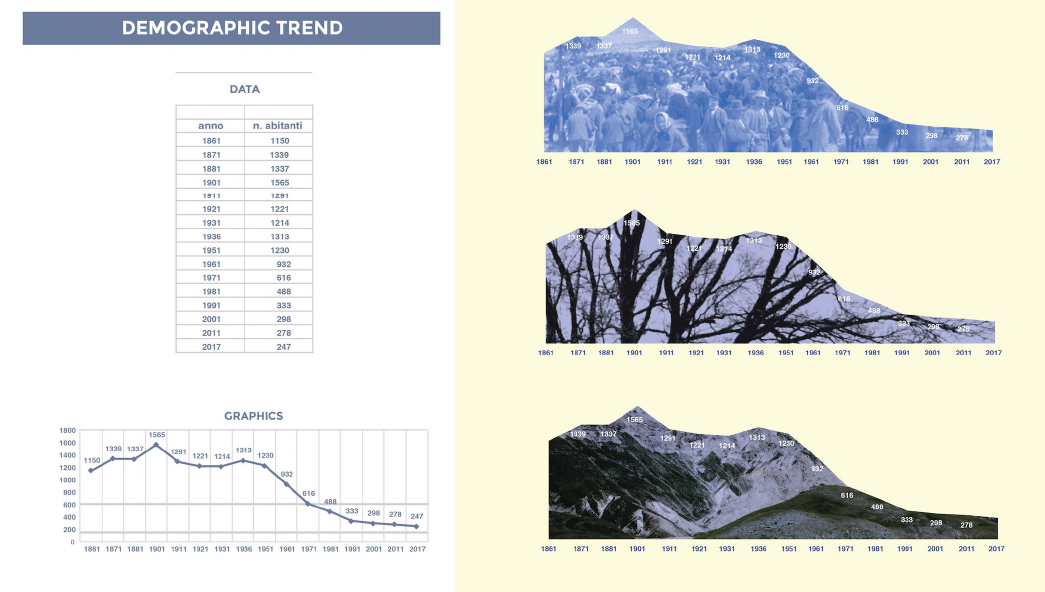
Figure 2. Representing a time series: the demographic trend.